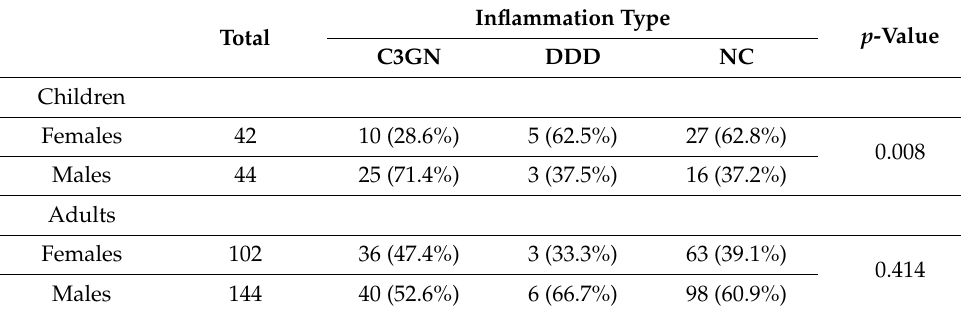
Table 1. Relationship between the type of inflammation and gender.